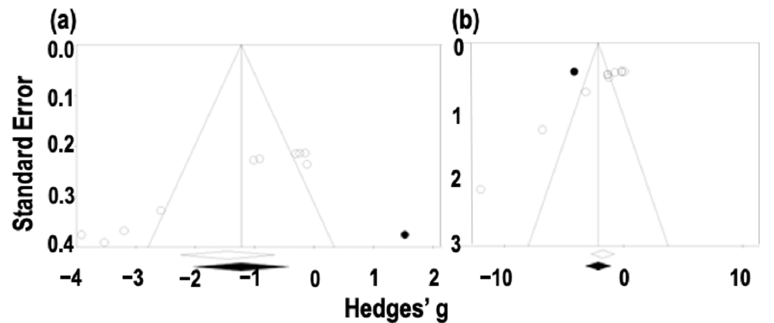
Figure 7. Funnel plots of standard error by Hedges’ g of serum/plasma TG ( a ) and TC ( b ) levels of DM rodents given either A. lappa and its related lignans or vehicles. Open and closed diamonds represent imputed overall effect sizes before and after Trim and Fill adjustment, respectively. An imputed study was shown as a closed circle.